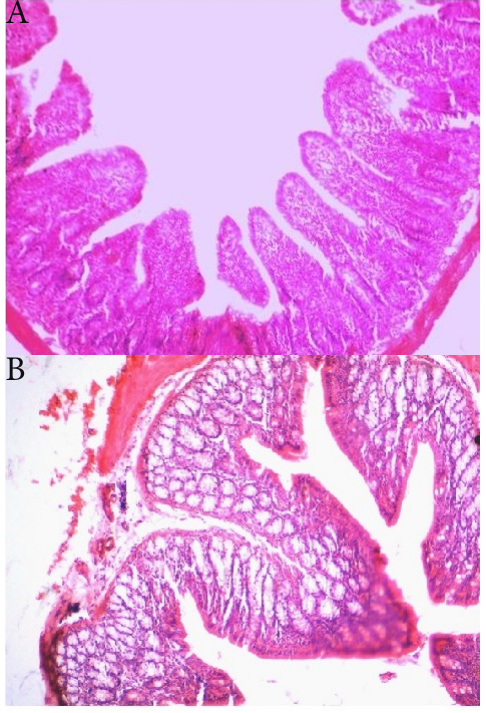
Figure 5. No pathologic lesion was observed in the rat’s small intestine (A) and colon (B) (H&E staining, 40X).